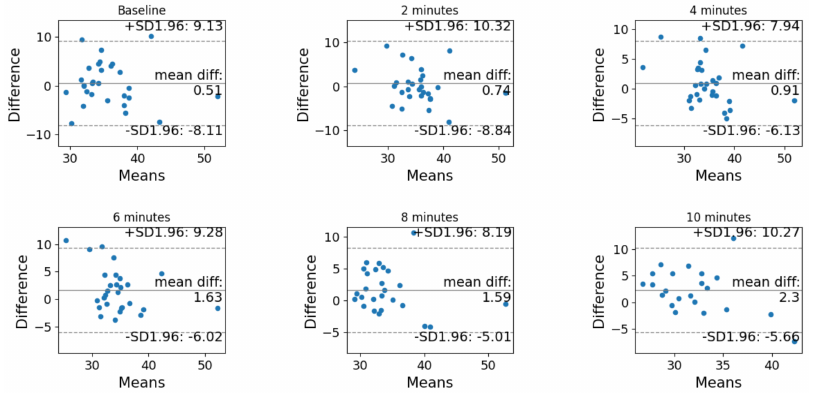
Figure 3. Bland–Altman analysis of the agreement between PtCO 2 and PaCO 2 before the correction at each timestamp (baseline, after 2 min, after 4 min, after 6 min, after 8 min and after 10 min).